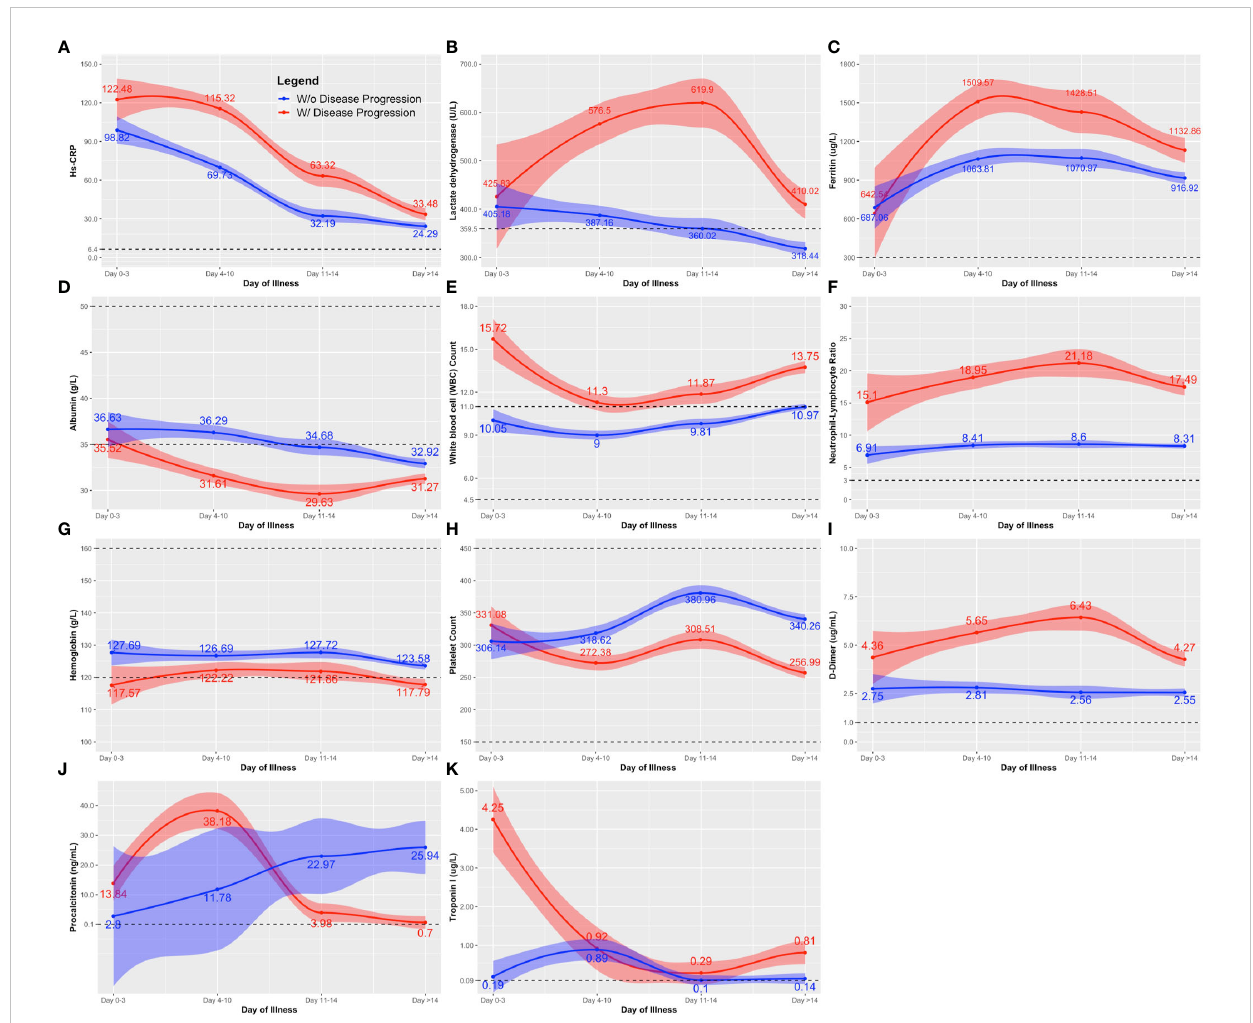
FIGURE 1 Comparison of the clinical laboratory biomarkers throughout the course of illness between COVID-19 patients with and without disease progression. The clinical biomarkers are: (A) hs-CRP; (B) lactose dehydrogenase (LDH); (C) Ferritin; (D) albumin; (E) white blood cell (WBC); (F) neutrophil- lymphocyte ratio; (G) hemoglobin; (H) platelet count; (I) D-dimer; (J) procalcitonin; and (K) Troponin. Line estimates were created using Locally Weighted Scatterplot Smoothing (LOWESS) showing 95% CI as shaded area around the line estimate. Points at each day interval represent mean estimate computed at that time point. Broken lines show the normal ranges of the